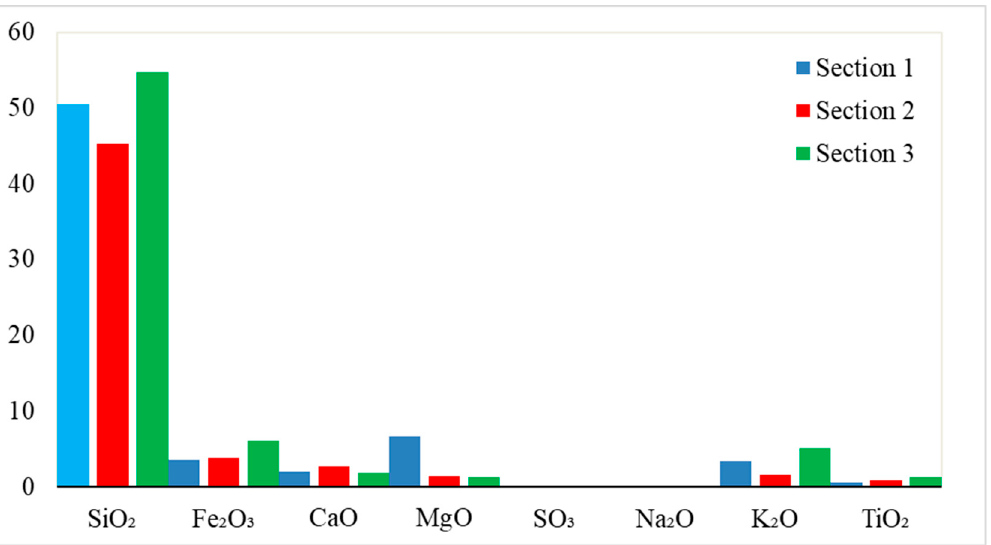
Figure 17. Histogram comparing the averages of the main oxides.